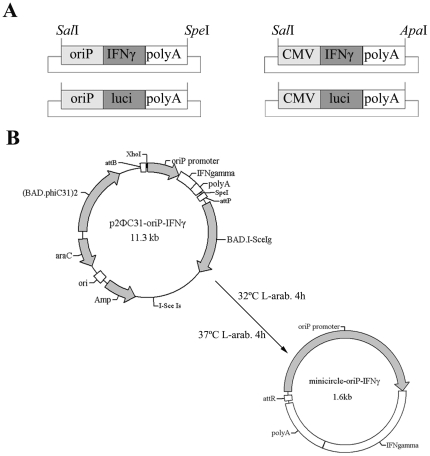
Schematic diagram of the construction of mc-oriP and control vectors and the generation of mc-oriP-IFNγ.(A) Diagram of the minicircle vectors carrying the IFNγ gene or firefly luciferase gene under the control of the oriP promoter (left) or CMV promoter (right). (B) Flow chart of ФC31 integrase-mediated intramolecular recombination of p2ФC31-oriP-IFNγ. The resulting product is minicircle-oriP-IFNγ. Amp, ampicillin resistance gene; BAD, araBAD promoter; araC, araC repressor; attB, bacterial attachment site; attP, phage attachment site; attR, right hybrid sequence; I-SceIg, I-SceI gene; I-SceIs, I-SceI cutting site; L-arab., L-arabinose.